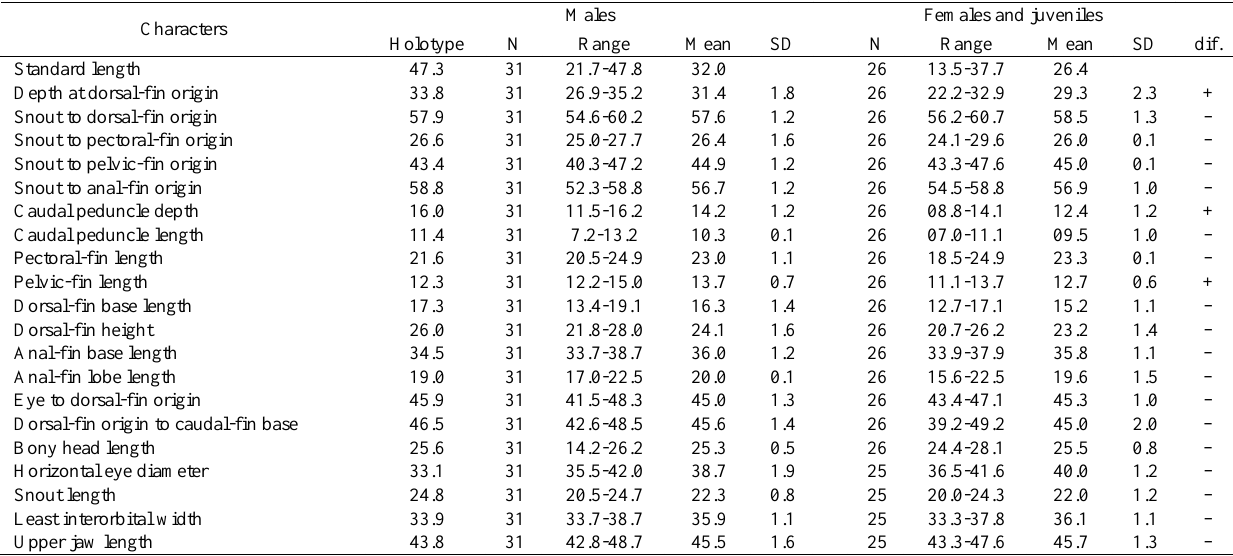
Table 11. Morphometrics of Mimagoniates rheocharis . Standard length is expressed in mm; measurements through bony head length are percentages of standard length; the last four entries are percentages head length. A plus sign under the abbreviation dif. indicates there is a significant statistical difference between the males and females in the particular character indicated. Specimens are from near rio Grande, Santa Catarina, MZSUP 40280, MCP 13616, and USNM 279878, USNM 306339. SD = Standard